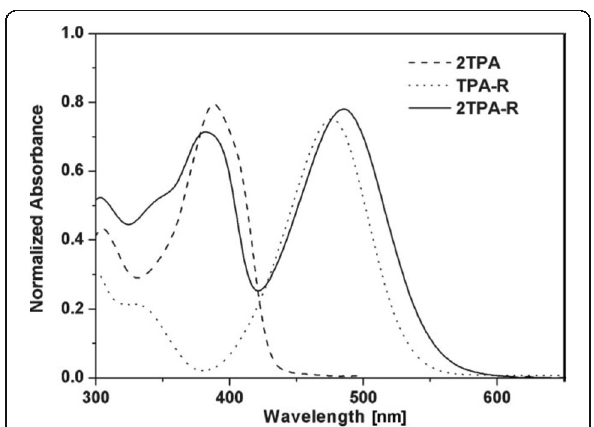
Fig. 17 Absorption spectra of 2TPA, TPA-R, and 2TPA-R in CH 2 Cl 2 solutions